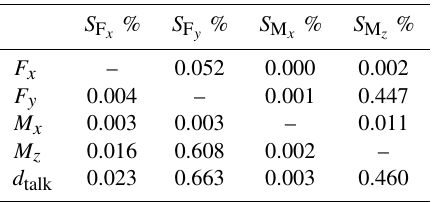
Table 2. Relative uncertainty of strain gauges for linearity devia- tion and hysteresis ( d lh ), repeatability ( d rp ) and temperature influ- ence ( d TK ) (Schwartz, 2006) as well as the crosstalk ( d talk